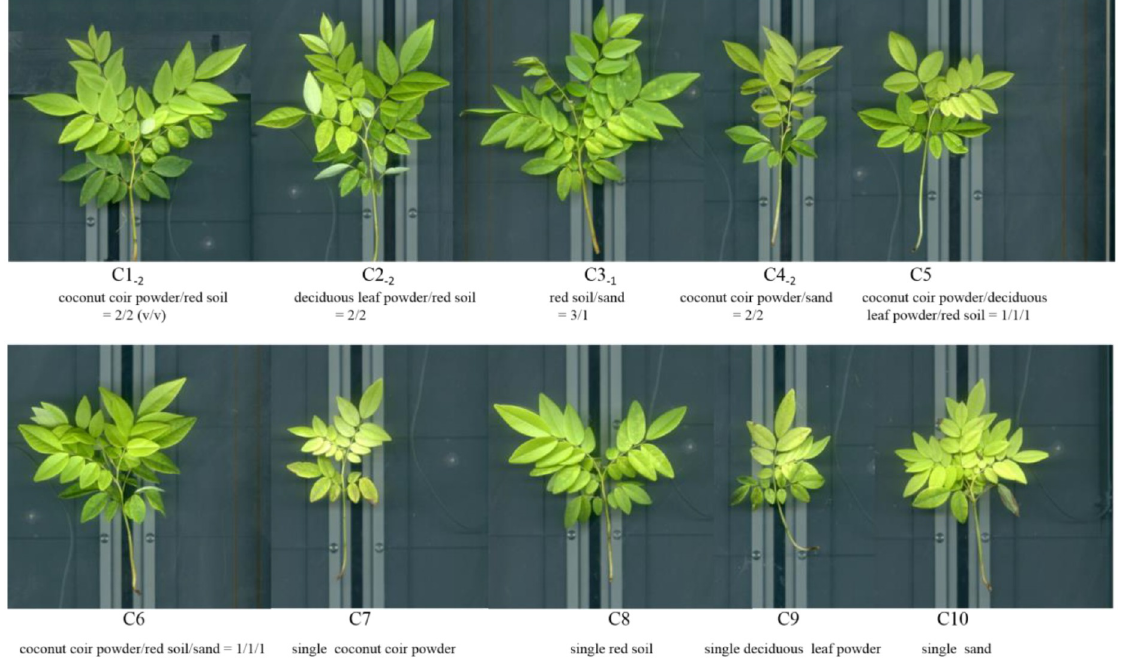
Fig 1. Above-ground morphological traits of D . odorifera cultured by different substrates.